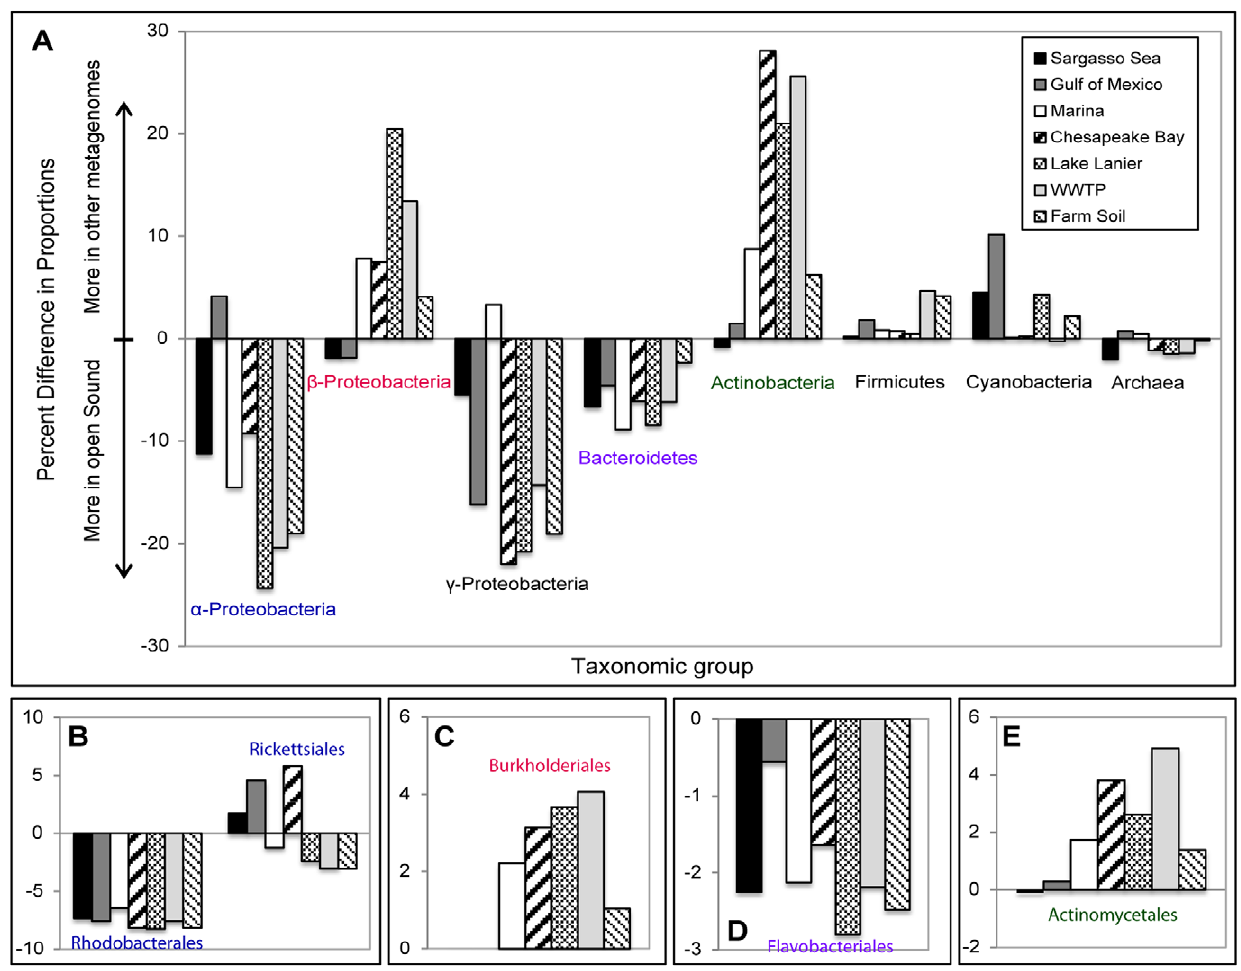
Figure 3. Over- and under-representation of predominant taxa in selected biomes relative to the open Puget Sound metagenome. (A) Overall taxa, (B) a -Proteobacteria, (C) b -Proteobacteria, (D) Bacteroidetes and (E) Actinobacteria. The difference in proportions refers to the percent difference in the relative abundances of a given taxa between two locations. Only taxa with a difference of proportions . 1% are shown. Negative values indicate higher relative abundance in the Puget Sound (p , 10 2 15 for all comparisons). See Materials and Methods for references describing the additional metagenomes used for comparison. A unique taxonomic signature was identified for the Puget Sound consisting of an over- representation of a -Proteobacteria, c -Proteobacteria and Bacteriodetes and an under-representation of b -Proteobacteria and Actinobacteria.